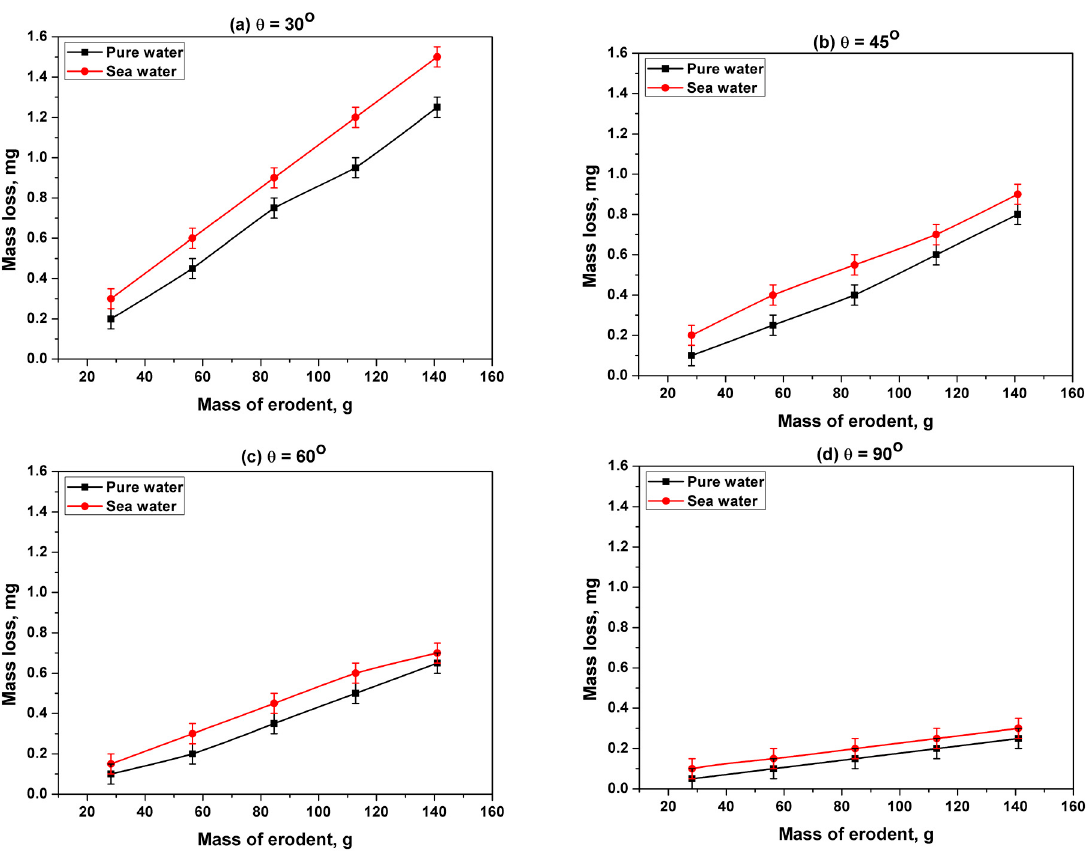
Figure 10. Mass loss of the SLMed Ti-6Al-4V alloy due to slurry erosion in pure water and seawater at impact angles of ( a ) 30°, ( b ) 45°, ( c ) 60°, and ( d ) 90°.